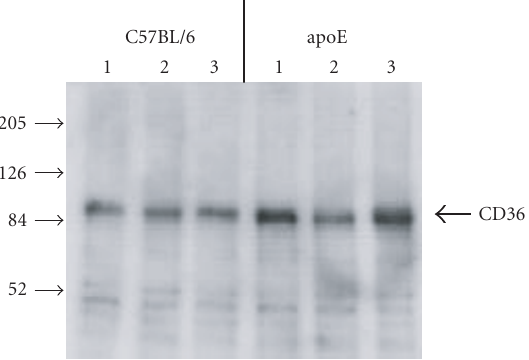
(a) Representative western blot showing CD36 protein expression lev- els in testis of chow fed apoE − / − mice at 16week of diet, in comparison to wild type (C57BL/6). Blots contained 50 µ g of purified membrane proteins. Three testis samples of di ff erent apoE − / − and C57BL6 mice were used. A control for loading and for quantification was also used on the Coomassie gel (not shown).